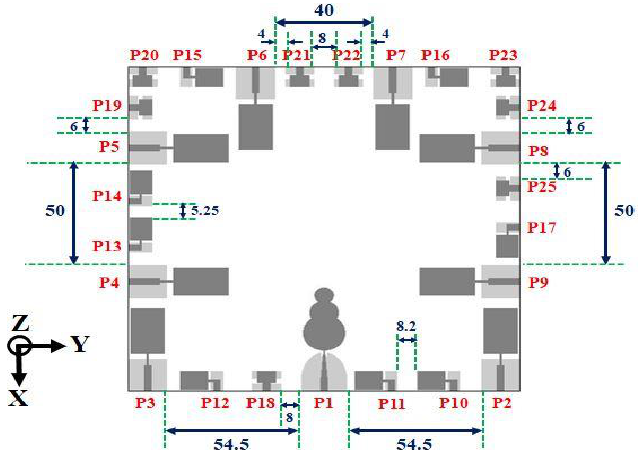
Figure 17. Inter-elemental spacing of the 25-port CR MIMO antenna. The reflection coefficients of all antennas in the proposed 25-port CR MIMO antenna